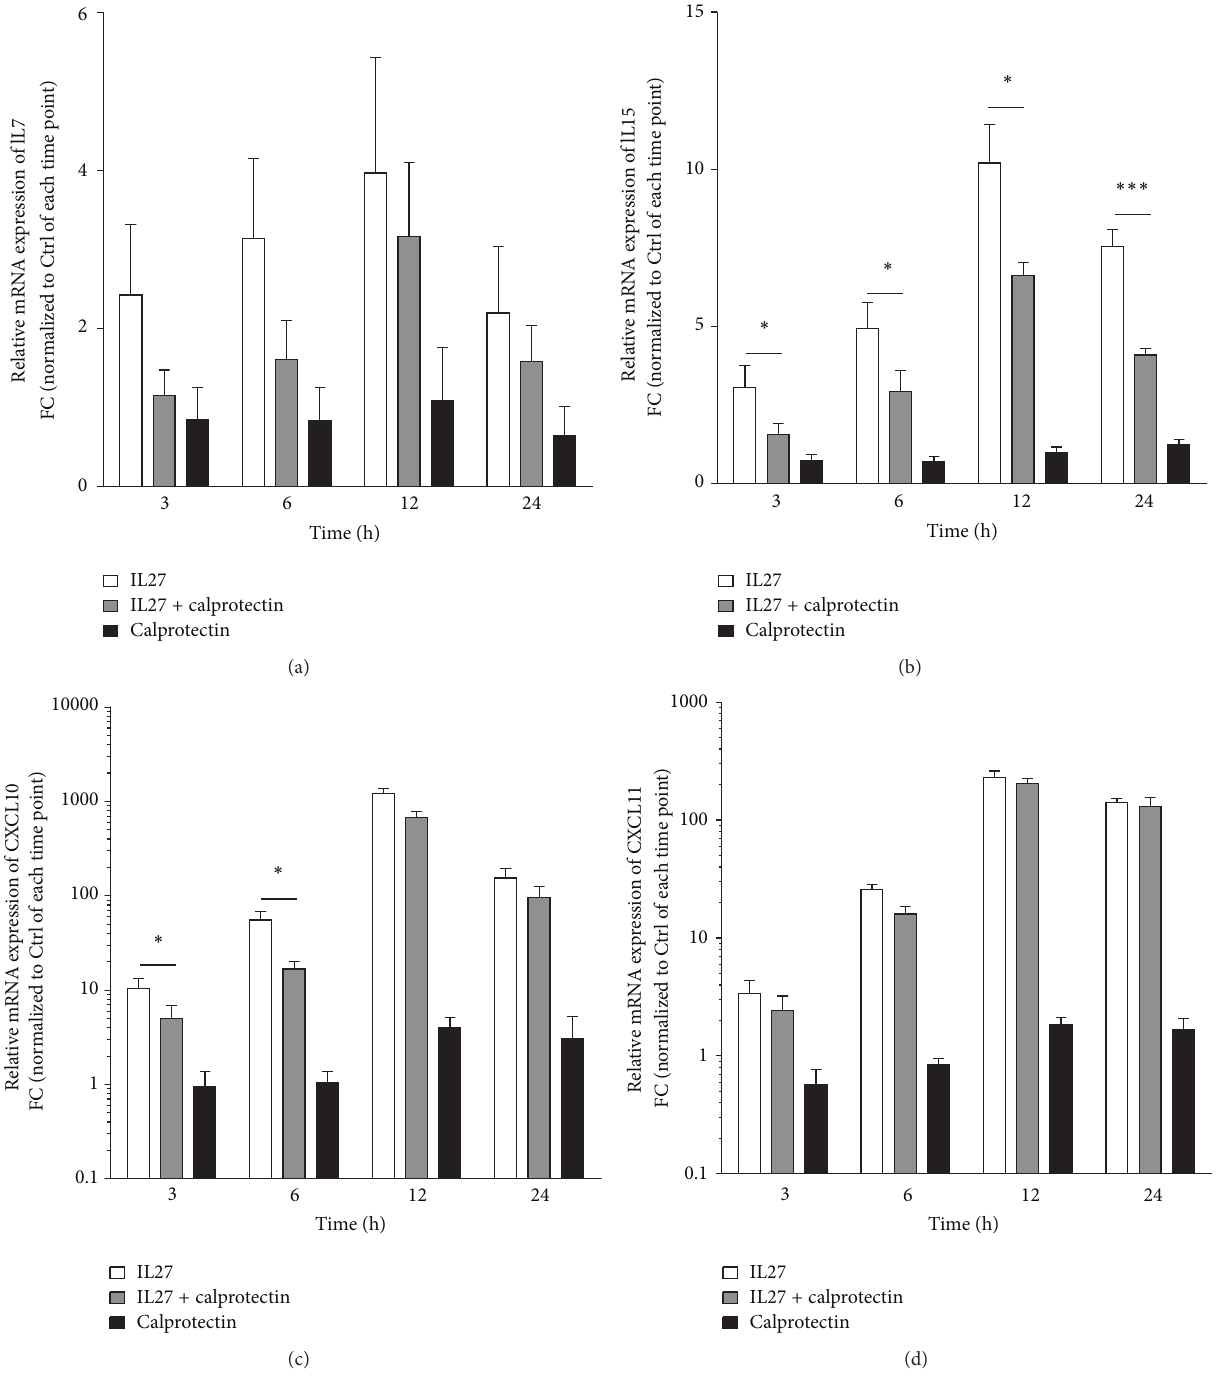
Figure 3: Effects of IL27, calprotectin, and IL27/calprotectin cotreatment on gene expression. Relative mRNA levels of IL7, IL15, CXCL10, and CXCL11 of IL27 (30 ng/mL) ± calprotectin (1 𝜇 g/mL)-stimulated HUVECs for 3, 6, 12, and 24 h are represented as mean ± SEM ( 𝑛 = 6 ). Indicated 𝑝 values are corresponding to significant differences between IL27 and IL27 + calprotectin: ∗ 𝑝 < 0.05 , ∗∗ 𝑝 < 0.01 , and ∗∗∗ 𝑝 < 0.001 .